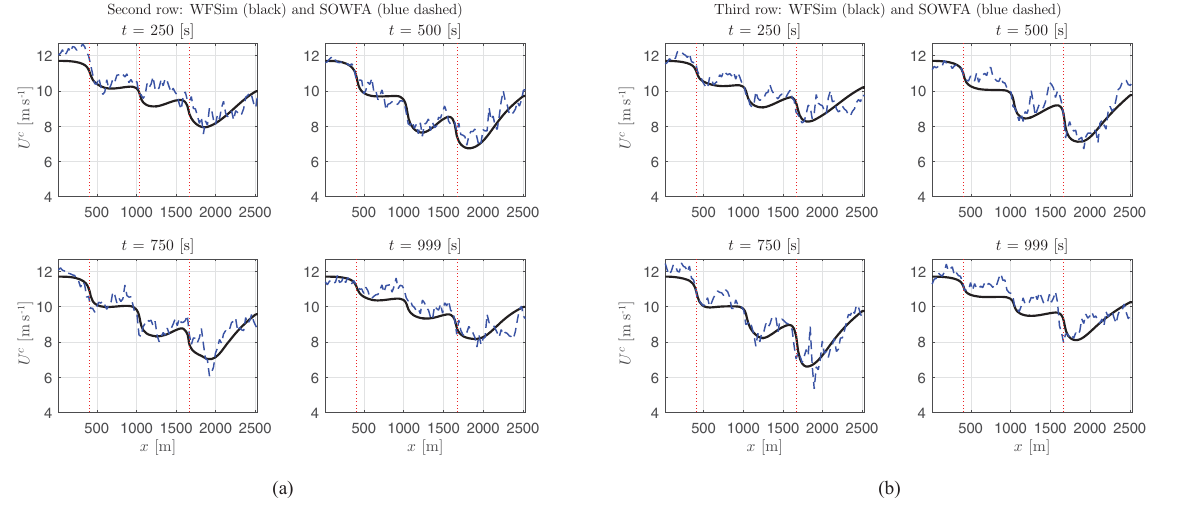
Figure 13. Mean flow centreline at four time instances through the second row (a) and third row (b) of turbines. The vertical red dashed lines indicate the positions of the turbines.